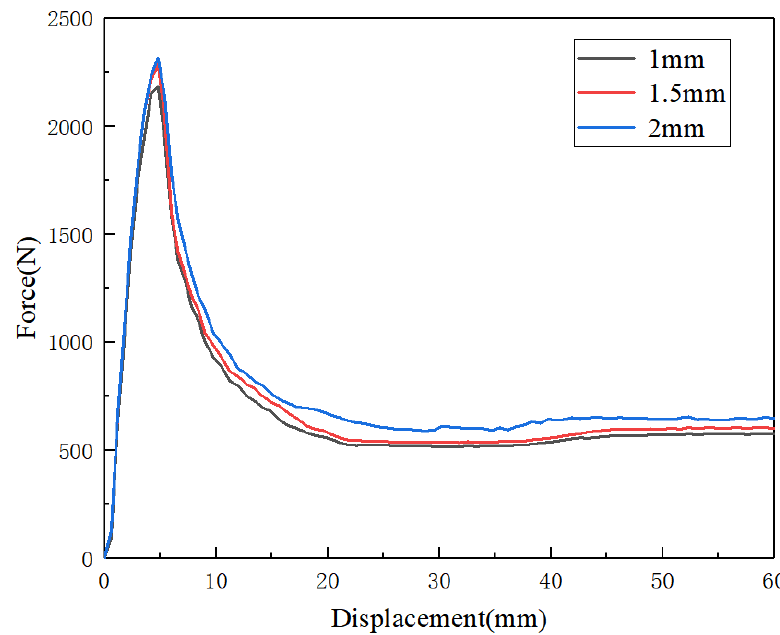
Figure 9. The load–displacement curves of [30°/ − 30°] RHCS when the velocity was 1 m/s.